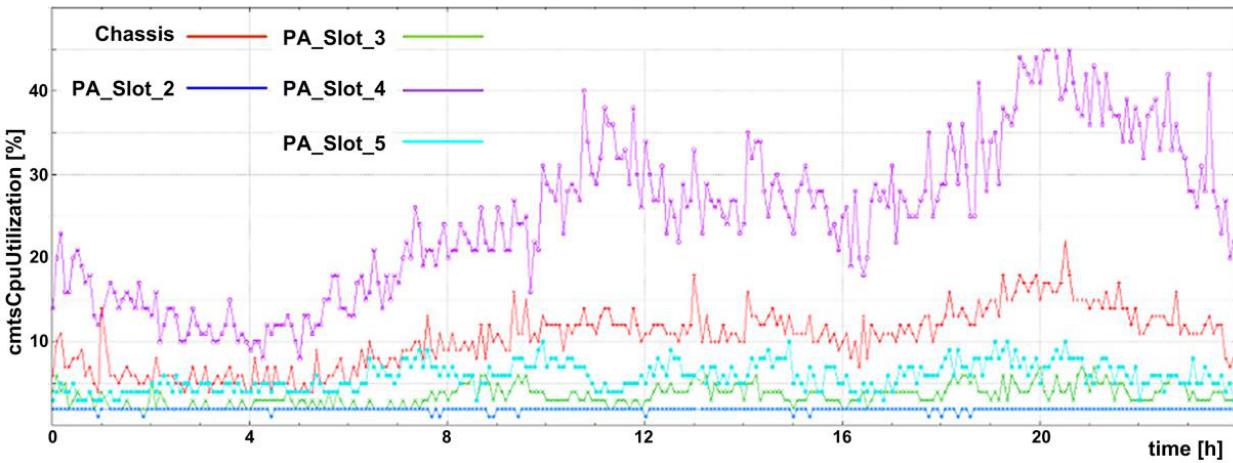
Figure 4. CMTS CPU utilization per unit.